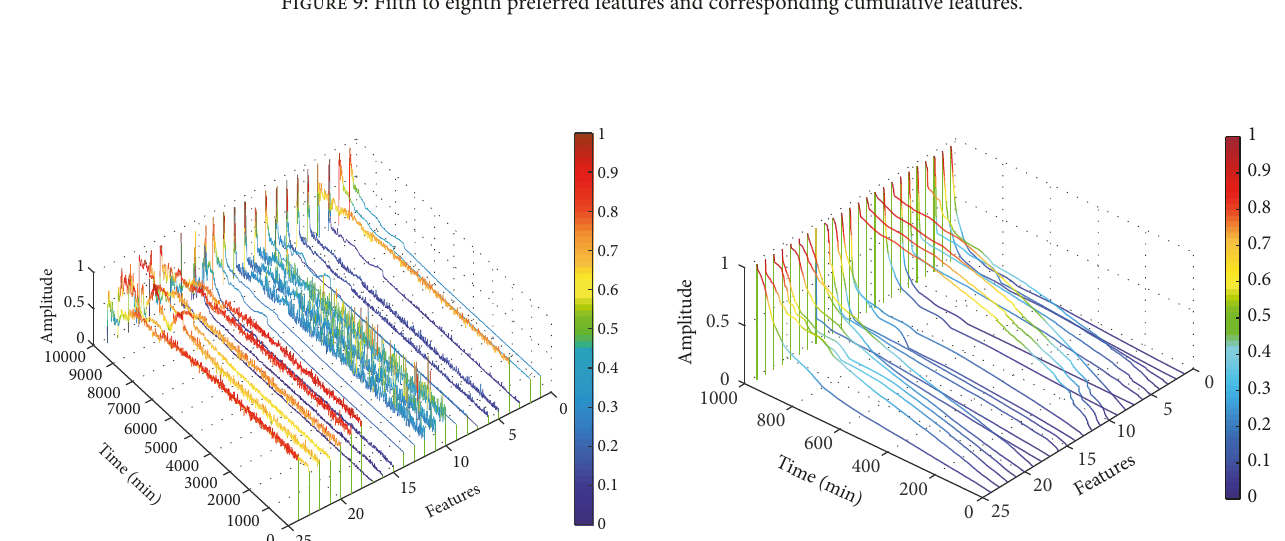
To quantitatively evaluate the performance of different methods, the MAPE and RMSE values of different degrada- tion indexes are summarized in Table 4. We note that the original